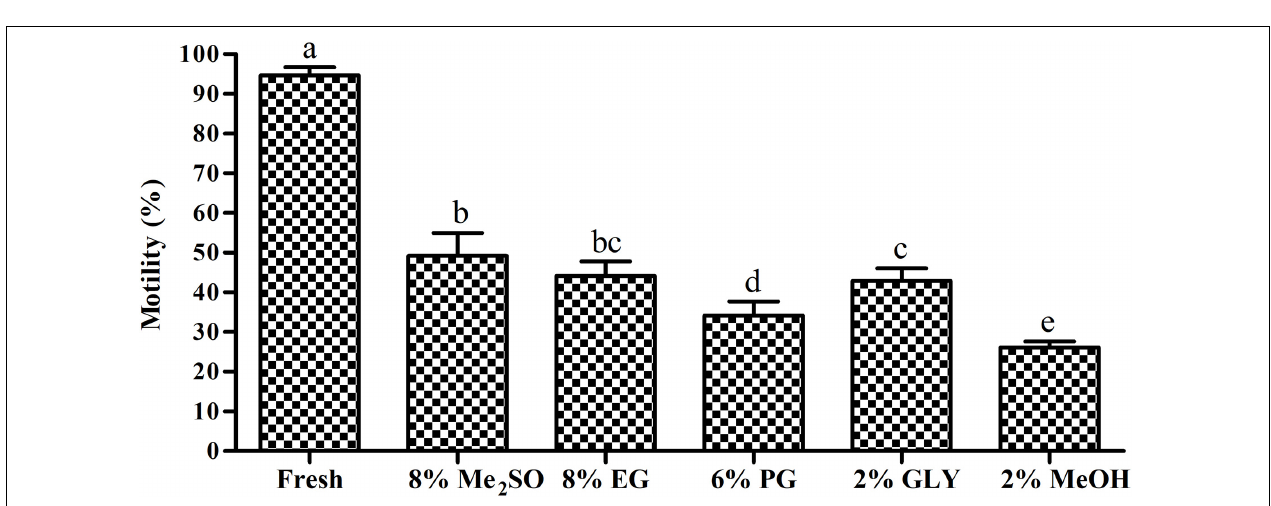
FIGURE 4 | Post thaw sperm motility of Pacific abalone, H. discus hannai . Results are expressed as mean ± standard deviation of mean (SD) ( n = 6). Significant ( p < 0.05) differences between different groups are indicated by superscript letters (a–c).